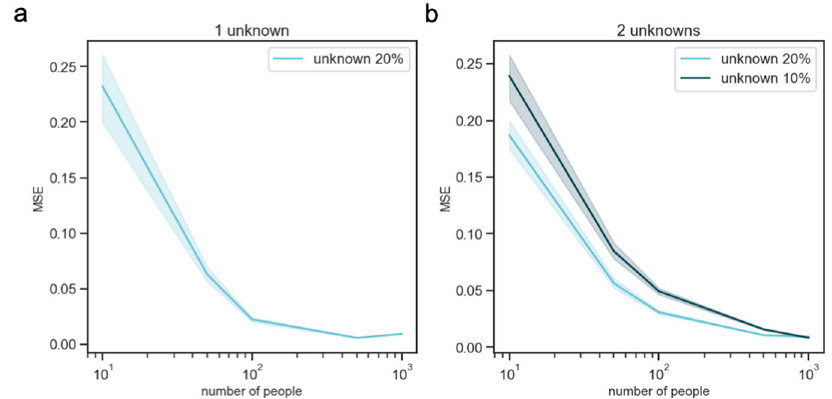
Fig. 4 Decomposition results for 50 independent simulations of cfDNA mixtures with missing cell types in the reference. We simulate cfDNA for 10, 50, 100, 500, and 1000 people, and exclude one cell type truly in the mixture at 20% (light blue) ( a ) or two cell types ( b ), one in the mixture at a mean proportion of 20% (light blue), and the other at 10% (dark blue). We calculate the MSE between the true unknown proportion and the CelFiE estimate for 50 simulation experiments. The 95% con fi dence interval is indicated by the light and dark blue